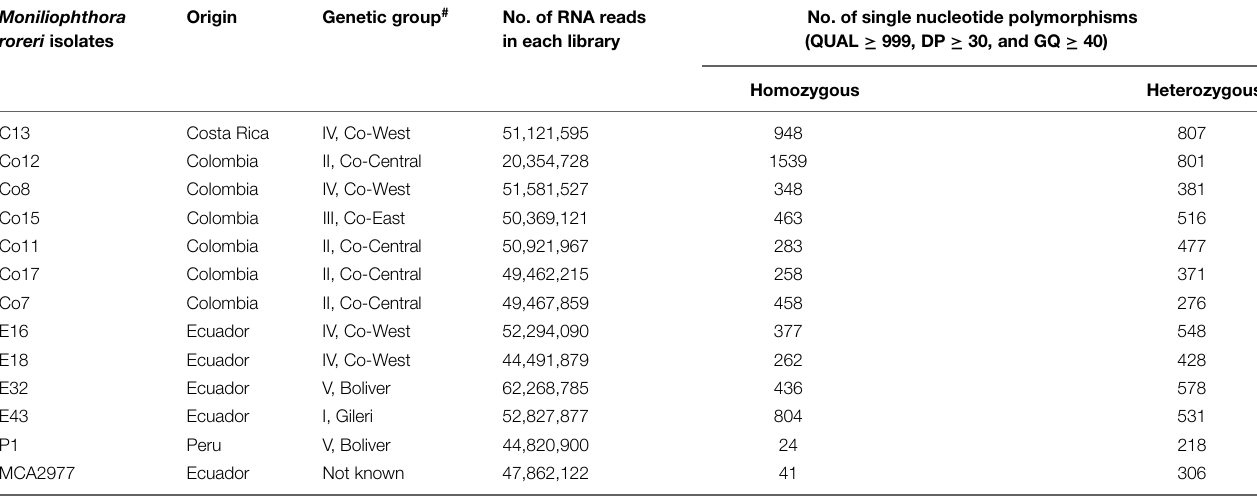
TABLE 1 | List of RNASequencing (RNASeq)